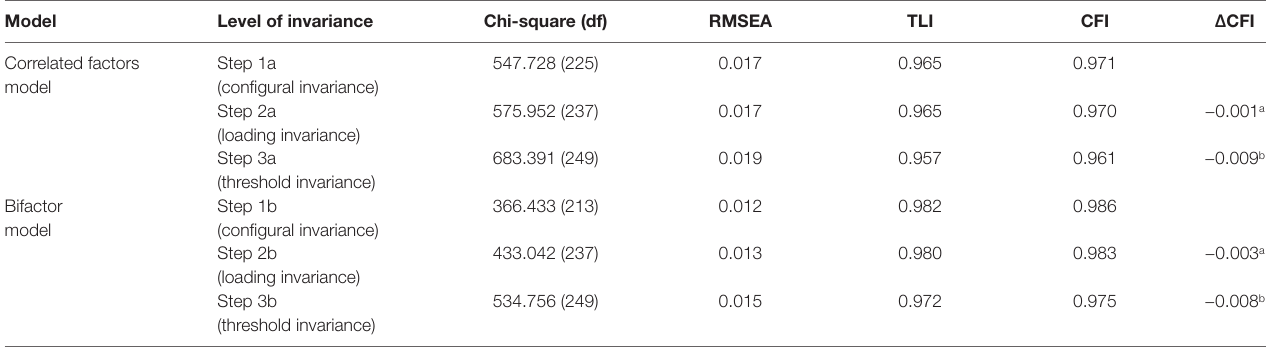
TABLE 1 | Longitudinal invariance of the correlated factors model and the bifactor model.